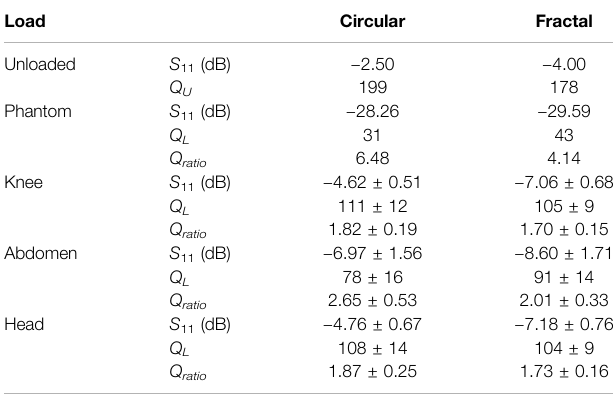
TABLE 1| The S 11 values (in dB), the Qvalues (unitless), and the ratio ofunloaded to loaded Q are reported in this table for both the circular and fractal coil over various loads. A mean and standard deviation are reported for the values calculated over the 11